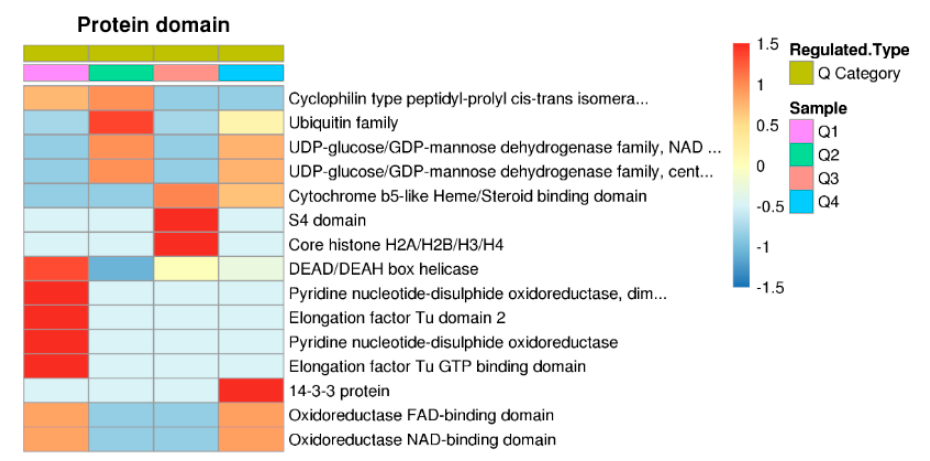
Figure 5. Protein domain based clustering analysis. Those domains at least enriched in one of the clusters with p value < 0.05 were clustered. The p value matrix was transformed by the function x = − log10 ( p value), and was then z-transformed for each domain. These z scores were clustered by one-way hierarchical clustering and visualized by a heat map using R-package.